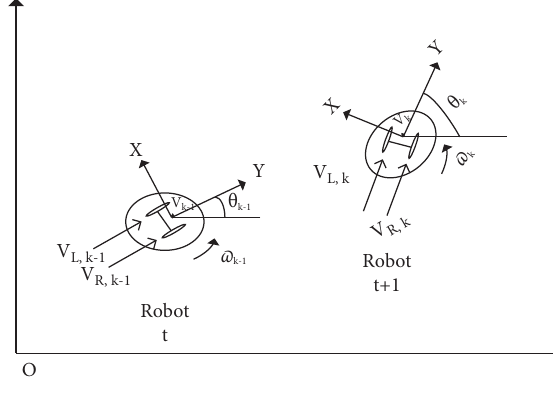
Figure 3: Model of mobile